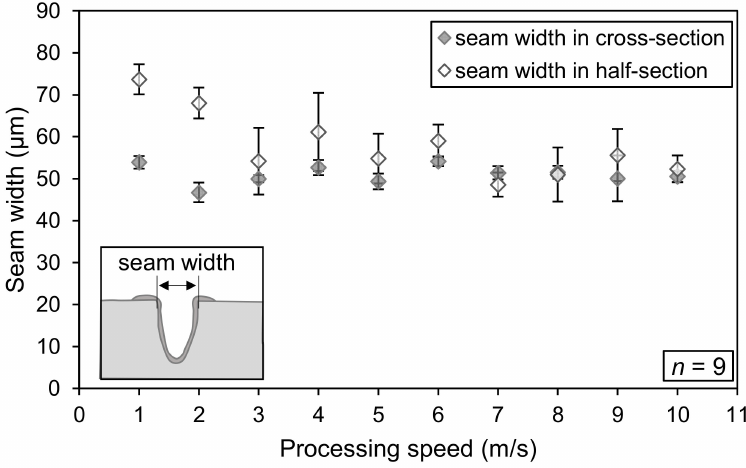
Figure 6. Resultant seam widths in the cross-section and half-section